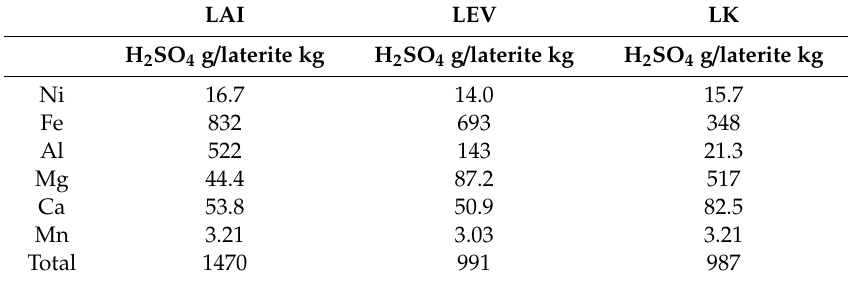
Table 3. Theoretical maximum acid consumption of Agios Ioannis (LAI), Evia Island (LEV) and Kastoria (LK) laterites as grams sulfuric acid per kg laterite. Metal dissolution to solution is assumed to be 100%. LAI